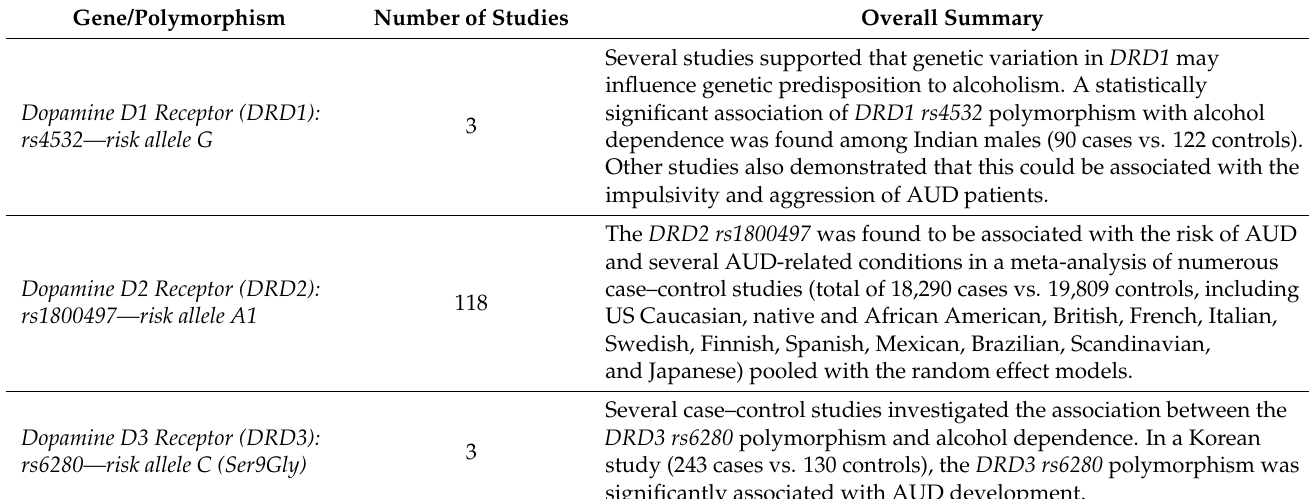
Table 1. Gene polymorphisms under consideration and the literature